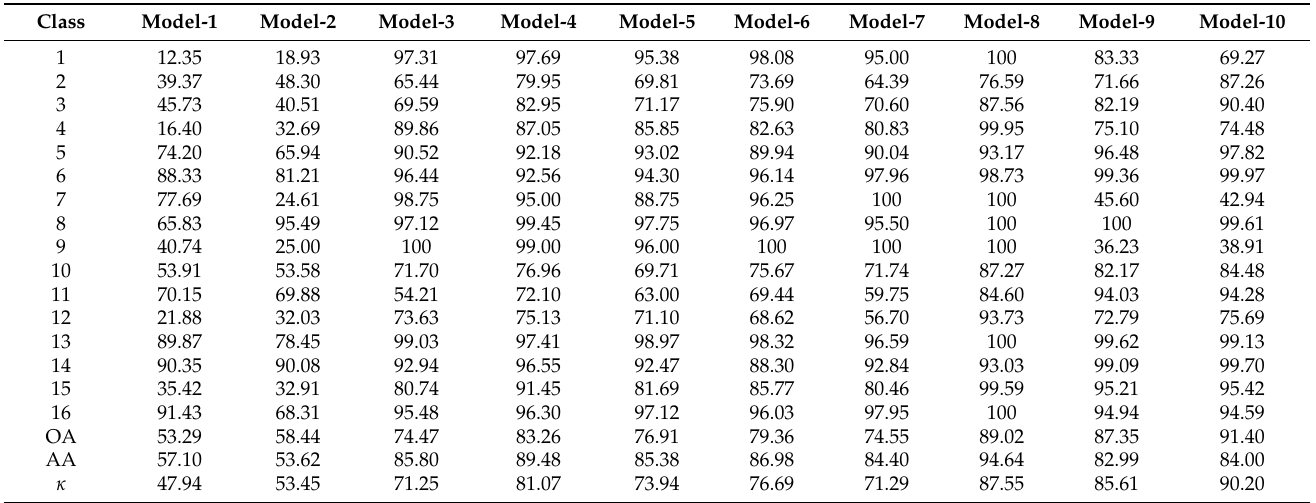
Table 5. Specific classification results of each model on the Indian Pines dataset, where Model-1, Model-2, ..., Model-10 represents SVM, PCA-SVM, CDCT-WF-SVM, CDCT-2DCT-SVM, SDWT-2DWT-SVM, SDWT-WF-SVM, SDWT-2DCT-SVM, Two-Stage, NSW-SVM and NSW-PCA-SVM, respectively, and the same in the other figures and